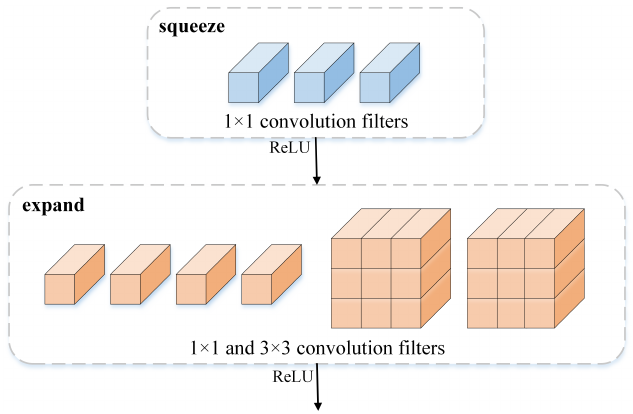
Figure 30. Fire protection module in SqueezeNet architecture.